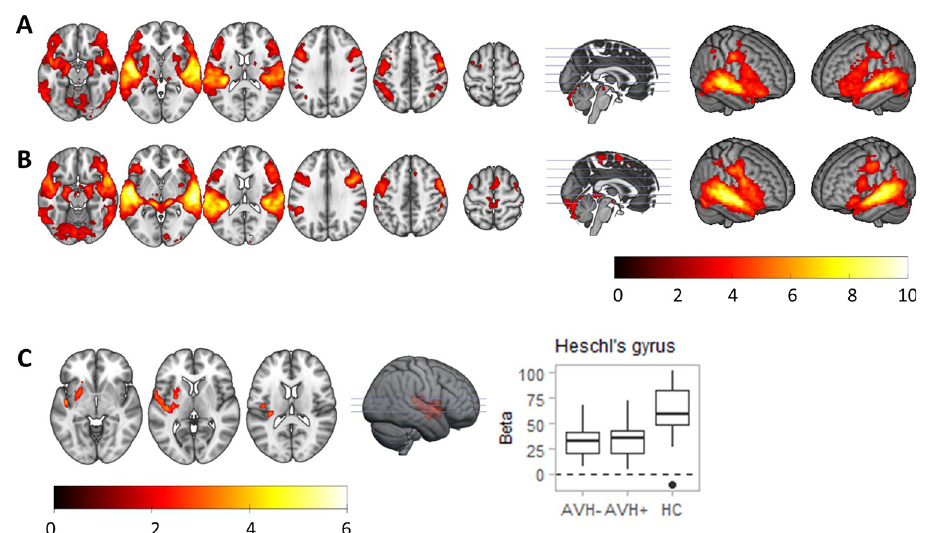
Fig 3. Activation maps for reversed > baseline for healthy controls (A) and patients with schizophrenia (B). (C) shows a region of differences between patients and controls in this contrast, located in Heschl’s gyrus. The boxplot depicts parameter estimates (beta values) in each group, showing hypoactivation in the patients. Color bars depict Z